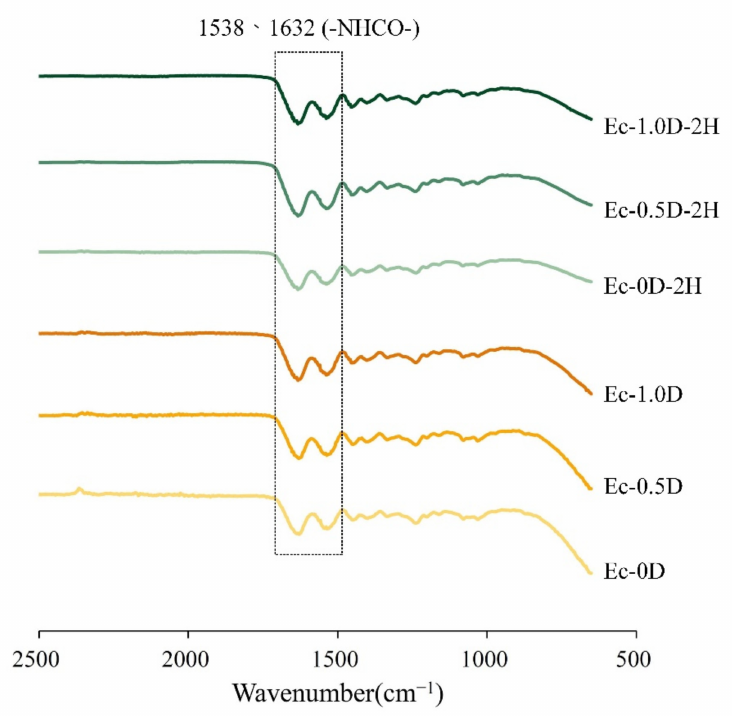
Figure 2. FTIR spectra of gelatin and hyaluronic acid crosslinked with EDC and loaded with hinokitiol/modified